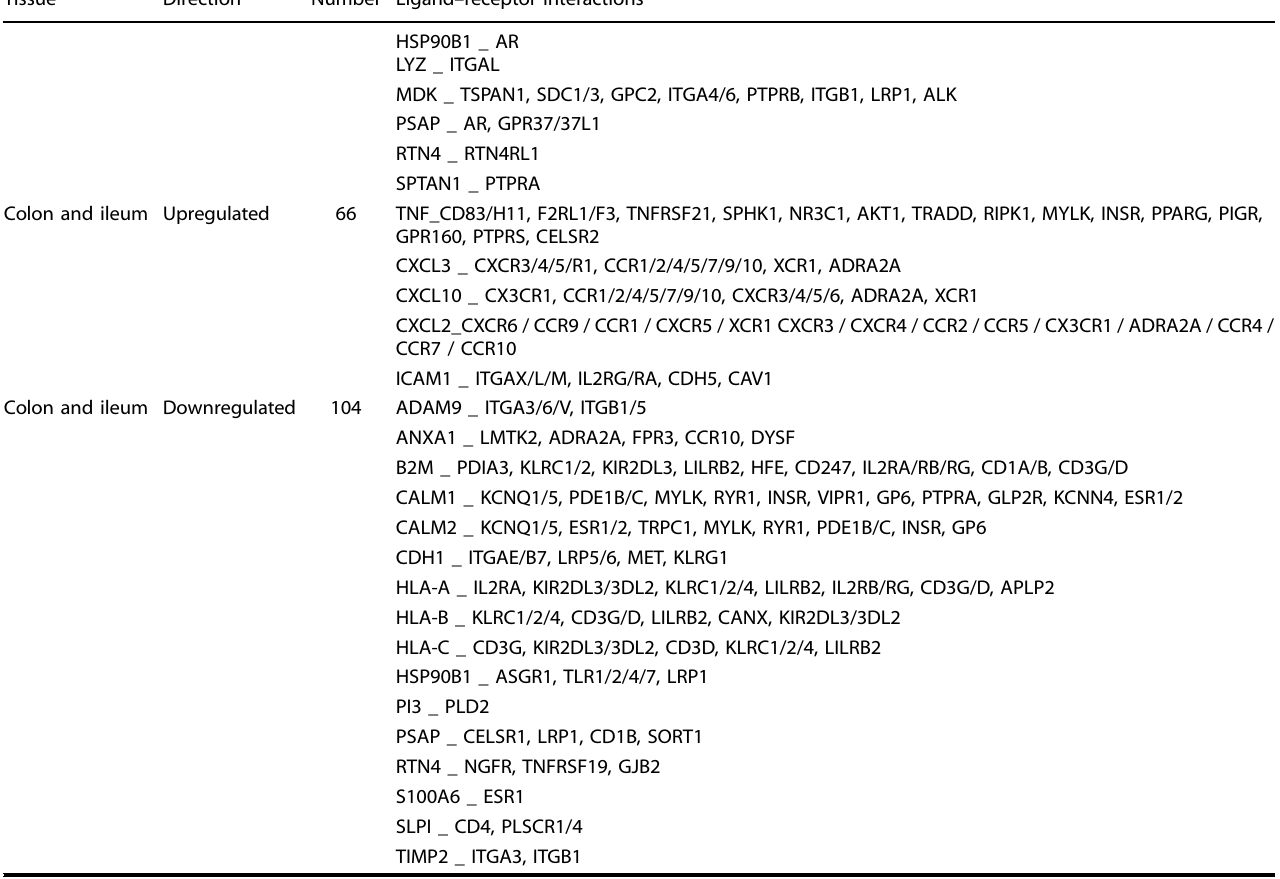
Table listing the number of ligand – receptor interactions in infected immature enterocytes – immune cells intercellular network that are unique or shared between the ileal and colonic networks. The direction column indicates the direction of the expression change epithelial ligand driving each intercellular interaction. Interactions are indicated as follows: ligand_receptor1, receptor2, receptor3. Receptors belonging to the same class (e.g. calmodulins) are indicated as follows: